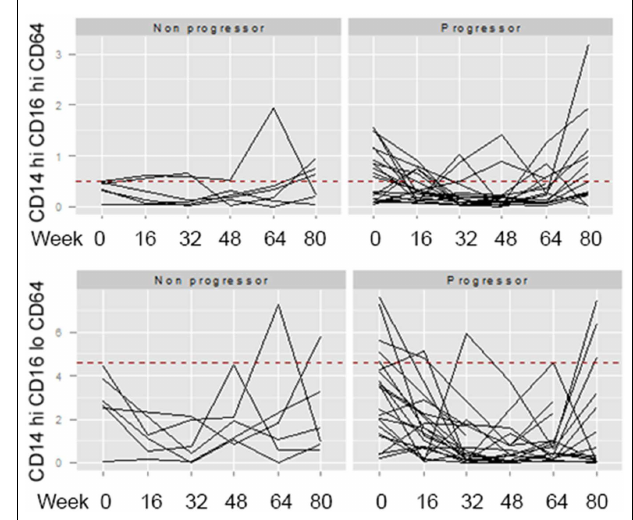
FIGURE 4 | Longitudinal analyses ofT cell phenotypes are highly variable .The percentage of CD4 CD25 (A) or CD8 CXCR3 (B) expressingT cells identified at longitudinal time points (weeks 0, 16, 32, 46, 64, and 80) were graphed.The dotted red line indicates the threshold above which this cell population was found to predict the patient reaching the combined endpoint in Table 5 . For both of these markers, univariate and multivariate analyses of the percentages at baseline significantly separated non-progressors from progressors. However, elevation of the marker at baseline, did not predict stable elevation of the marker over time.